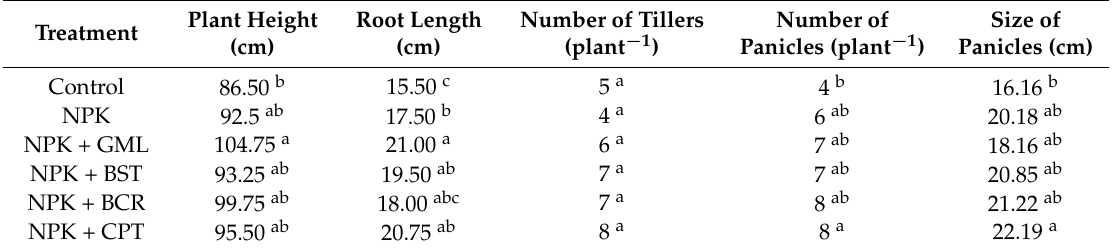
Table 2. Effect of soil amendments on the growth of rice plants.